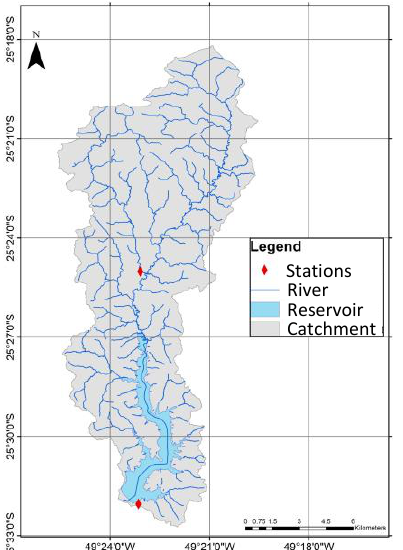
Figure 4. Location of pluviometric stations in the Passaúna catchment. Figure 5. Location of pluviometric stations in the Passa ú na